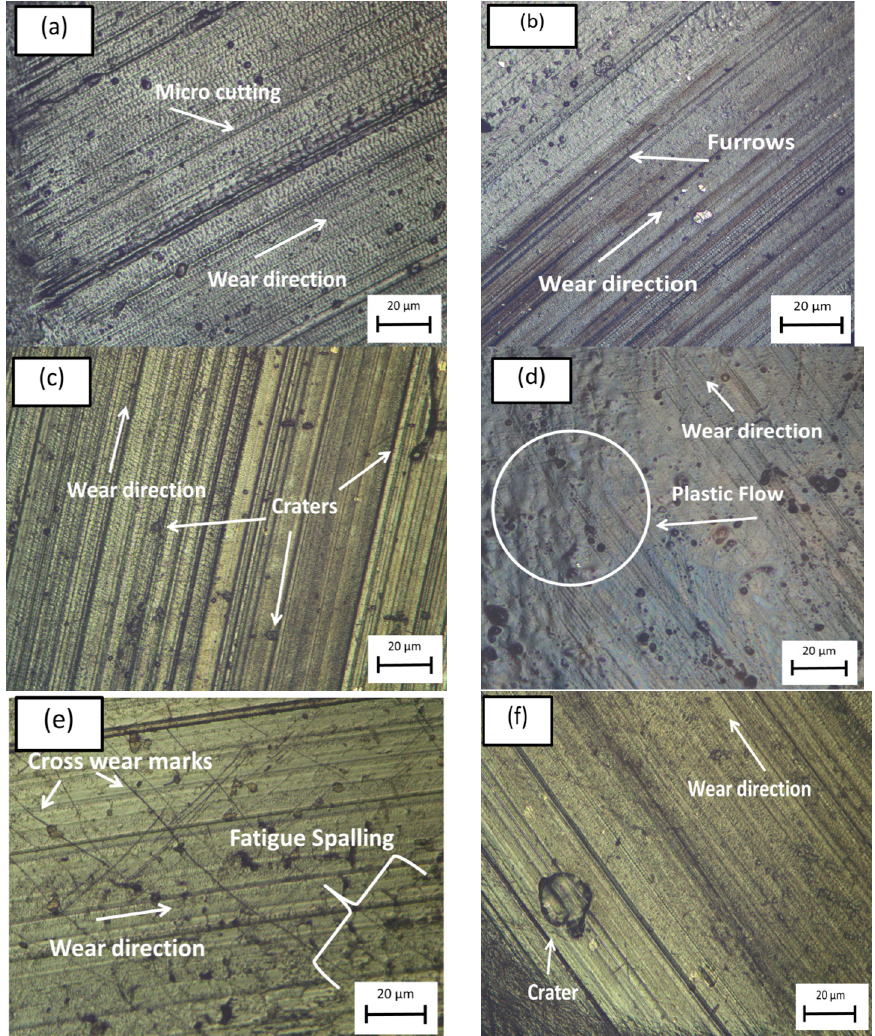
Figure 5. Optical microscope images of test samples (2 wt % UHMWPE/MWCNT nanocomposites with 60 min plasma treatment) under dry sliding conditions showing different wear mechanisms ( a ) microcutting; ( b ) furrows; ( c ) craters; ( d ) plastic flow and deformation; ( e ) cross-wear marks and fatigue spalling; and ( f ) wear crater.